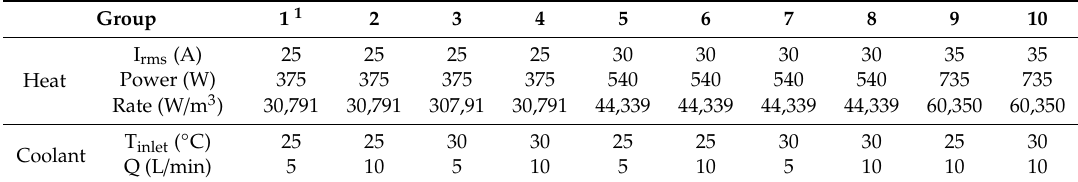
Table 5. Matrix list with variable boundary